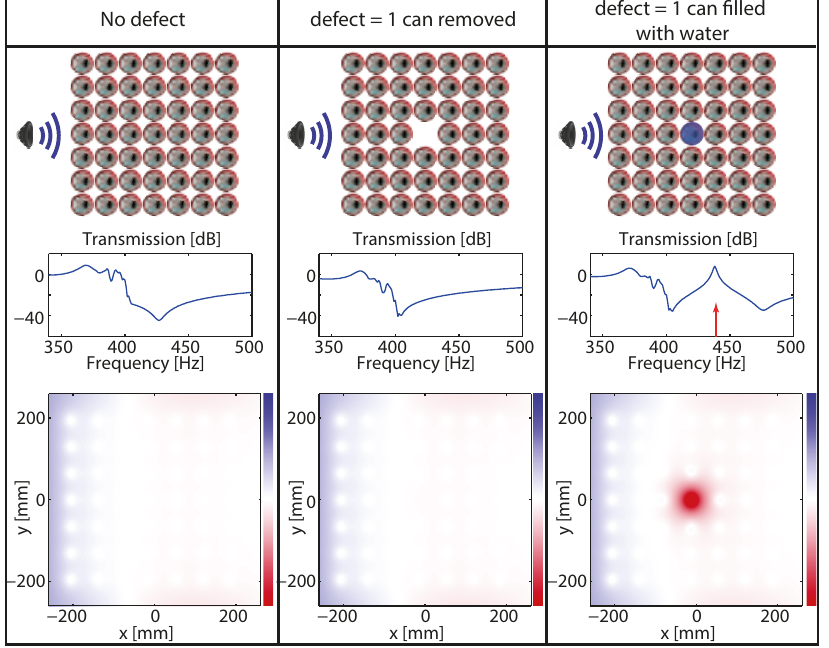
Figure 6. Simualtions corresponding to 3 different configurations: the unchanged 7 × 7 soda can array (left), an array where we removed the central can (middle) and an array where volume of the central can is reduced by 6 cL (right). For each, we show the spectrum of the transmission 1 cm above the array and the pressure field map at the frequency of 440 Hz. While removing a can cannot create a resonant cavity, introducing a detuned resonator permits to create a ( λ /15) 2 area cavity with an enhanced pressure field 5 times higher than the incident wave in the scanned